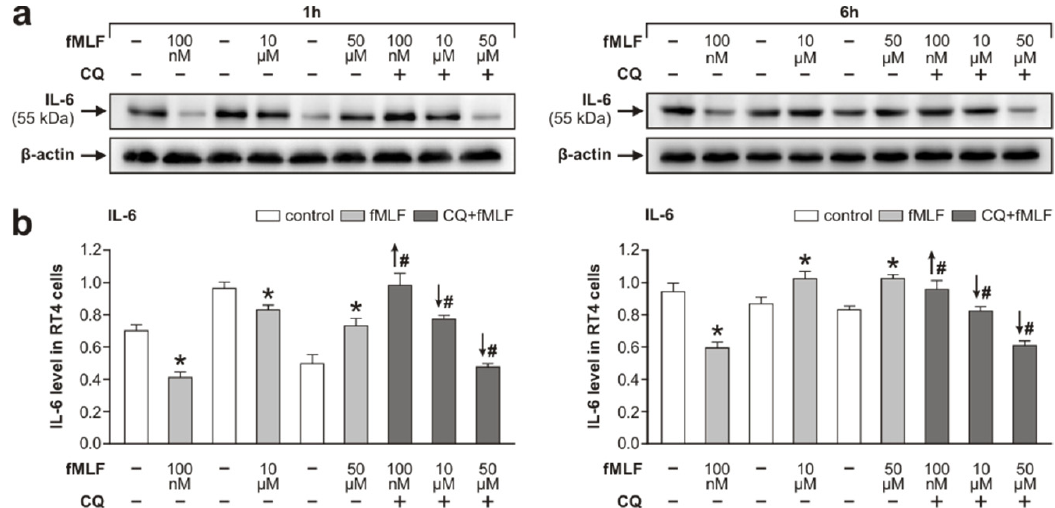
Figure 3. Western blot analysis of IL-6 protein levels in RT4-D6P2T cells after stimulation of N -formyl-methionyl-leucyl-phenylalanine (fMLF) at 100 nM, 10 µ M, and 50 µ M for 1 and 6 h and pretreatment with CQ (1 µ M). Panel ( a ) shows representative Western blots of IL-6 and β -actin as the housekeeping protein. The graphs ( b ) depict densitometric measurements of triplicate Western blots expressed as means ± SEM. * p < 0.05 compared to control, # p < 0.05 compared to stimulation with the relevant fMLF concentration without 1 µ M CQ, the up and down arrows indicate increased and decreased levels, respectively.